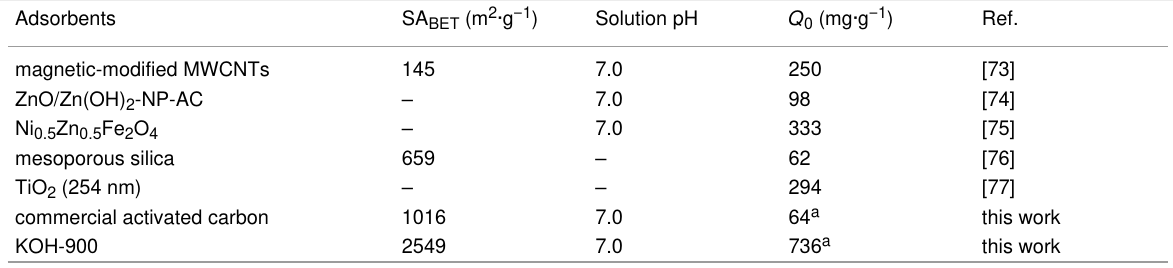
Table 2: Maximum adsorption capacity ( Q 0 ) of some reported adsorbents for the adsorption of JGB from water. Adsorbents